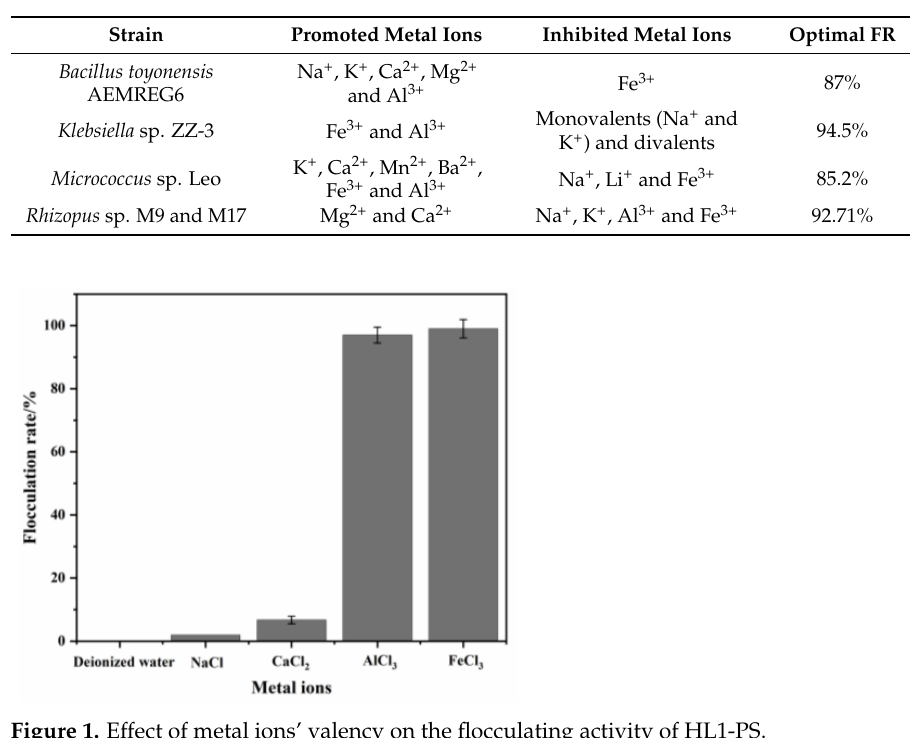
Figure 1. Effect of metal ions ’ valency on the flocculating activity of HL1-PS. The effects of metal ions on the flocculation performance are closely related to the flocculation mechanism. Charge neutralization is an important mechanism for the floc- culation reaction. The addition of metal ions neutralizes the charges and enhances the flocculating activity [21]. Cations mainly reduce electrostatic repulsion by neutralizing the negative charges of flocculants and suspended solids, thus, increasing the adsorption of polysaccharide bio-based flocculants on particle surfaces [22]. Monovalent cations produce loose bond structures compared to divalent cations, resulting in a decrease in flocculant density and size and flocculant resistance to shear [23]. Multivalent cations can bridge with negative functional groups on the biopolymer chain [5]. Therefore, the enhanced flocculating activity of HL1-PS by Fe 3+ and Al 3+ is mainly attributed to the bridging effect of multivalent cations, which also indicates that HL1-PS is a cation-dependent